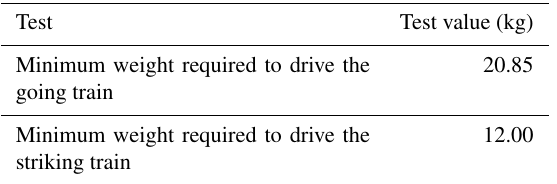
Table 3. Weight required to drive the going train and striking train.